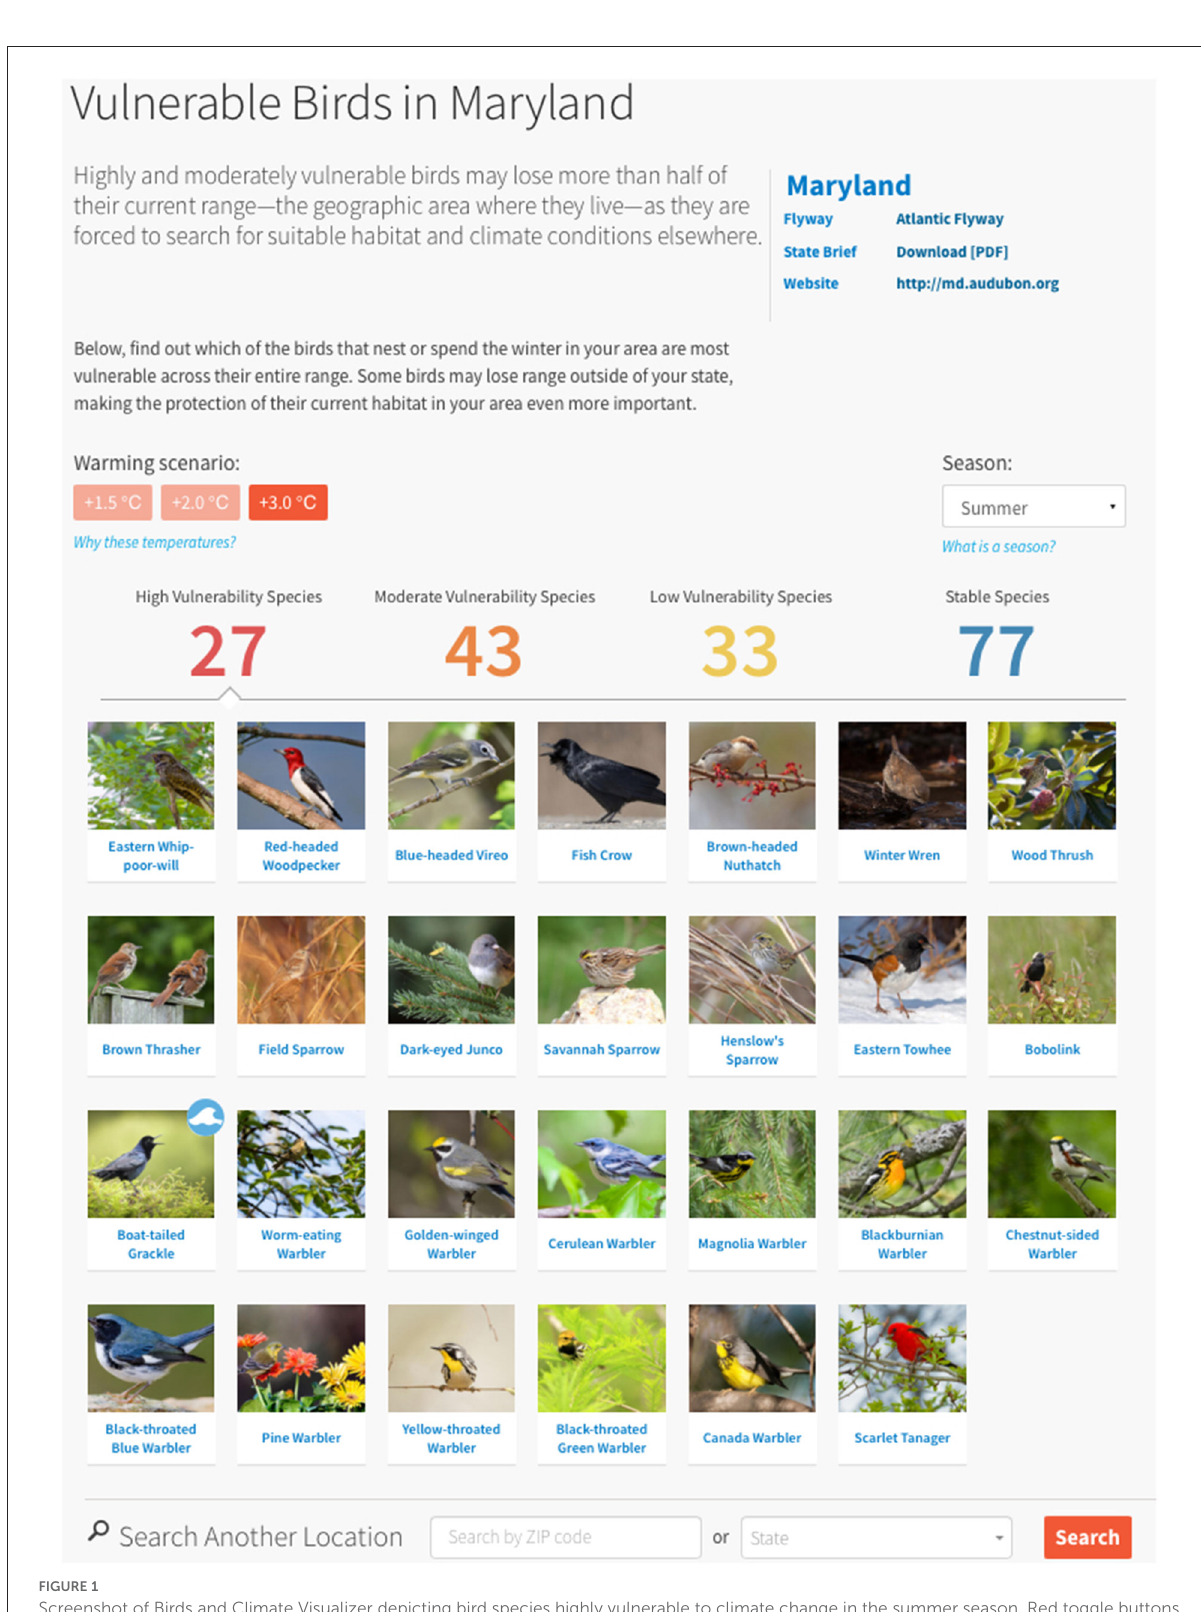
FIGURE1 Screenshot of Birds and Climate Visualizer depicting bird species highly vulnerable to climate change in the summer season. Red toggle buttons at the top allows users to switch between the 3.0 ◦ C, 2.0 ◦ C, and 1.5 ◦ C warming scenarios. A drop-down menu allows user to select the season (summer or winter). And, the user can select what level of vulnerability (high, moderate, low and stable) to explore species